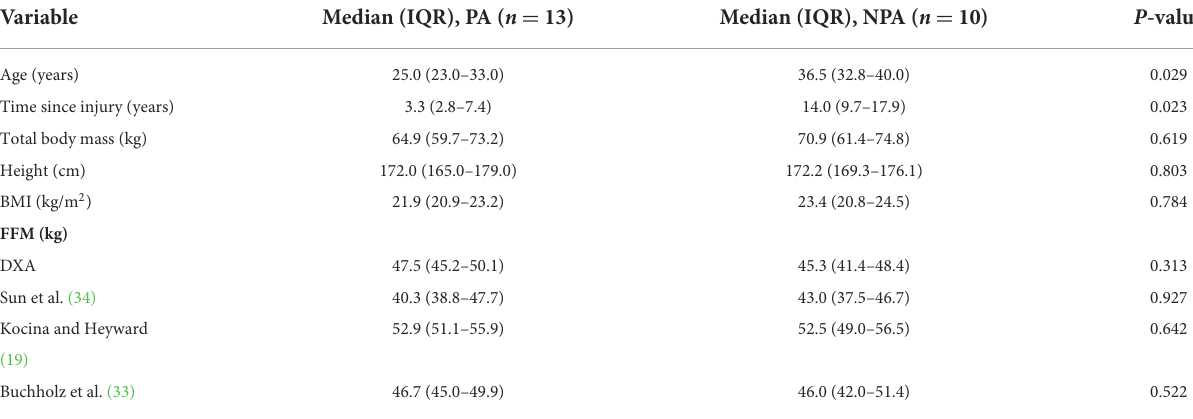
TABLE 2 c-SCI individuals’ general characteristics according to physical exercise.